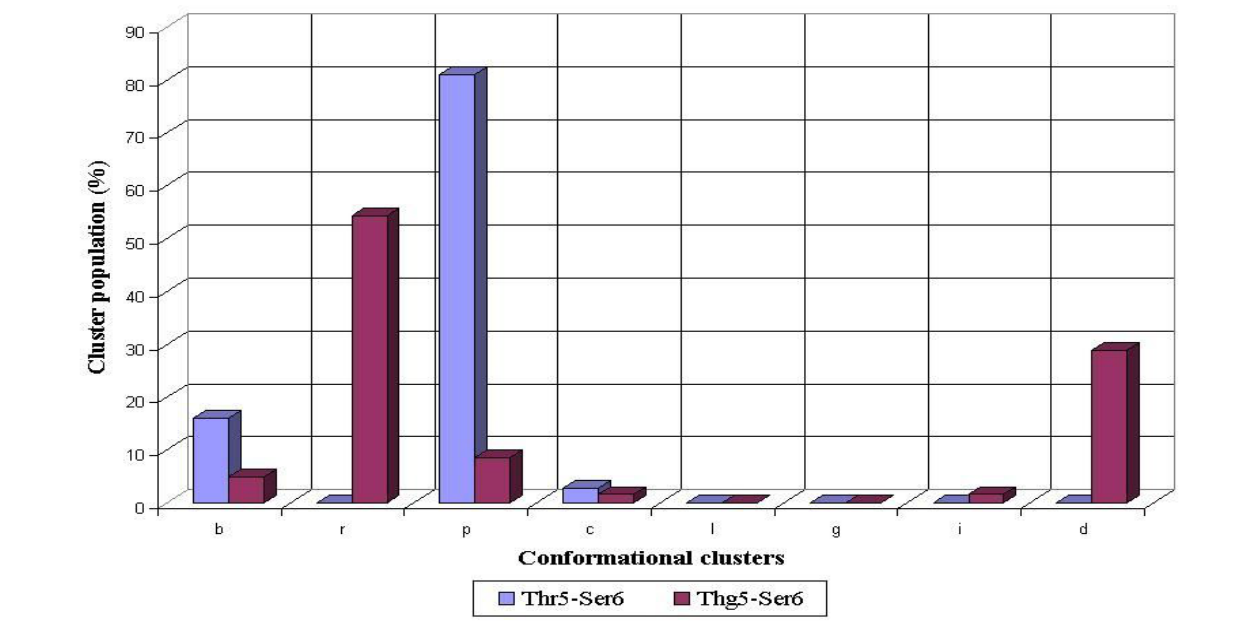
Figure 4. Conformational propensities of Ser6 flanking the nonglycosylated (Thr5-Ser6) and glycosylated (Thg5-Ser6) threonine residue during 1 ns MD simulations in peptides AHG21 and AHG21 (T5),